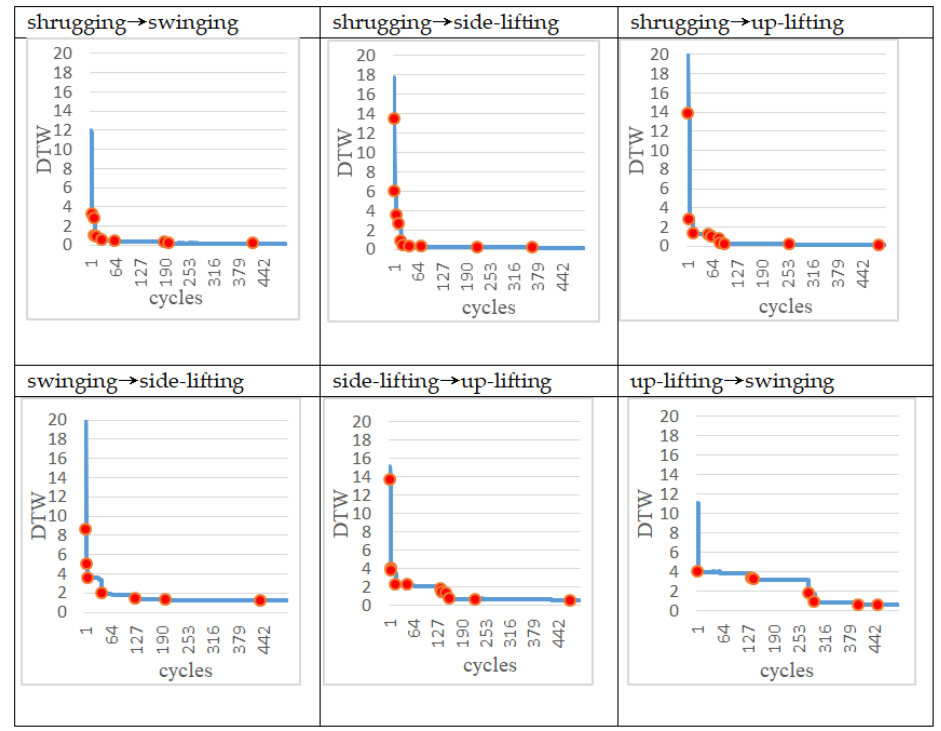
Figure 10. Learning progress of the ANM system for complex actions using two motors.